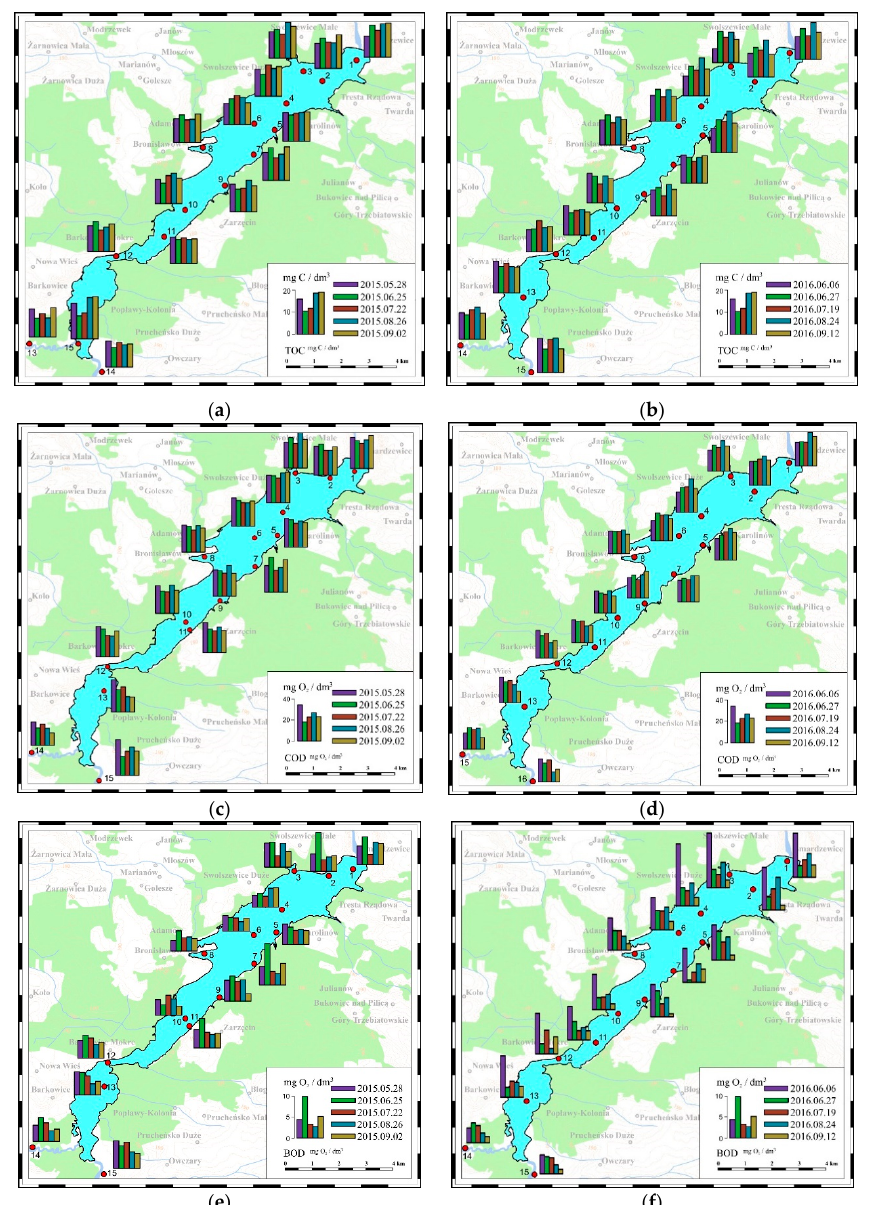
Figure 13. Changes in the concentration of TOC (Total Organic Carbon, ( a , b )) (mg C/dm 3 ), COD (Chemical Oxygen Demand, ( c , d )) (mg O 2 /dm 3 ) and BO D (Biochemical Oxygen Demand, ( e , f )) (mg O 2 /dm 3 ) in the Sulejow Reservoir in 2015 and 2016.